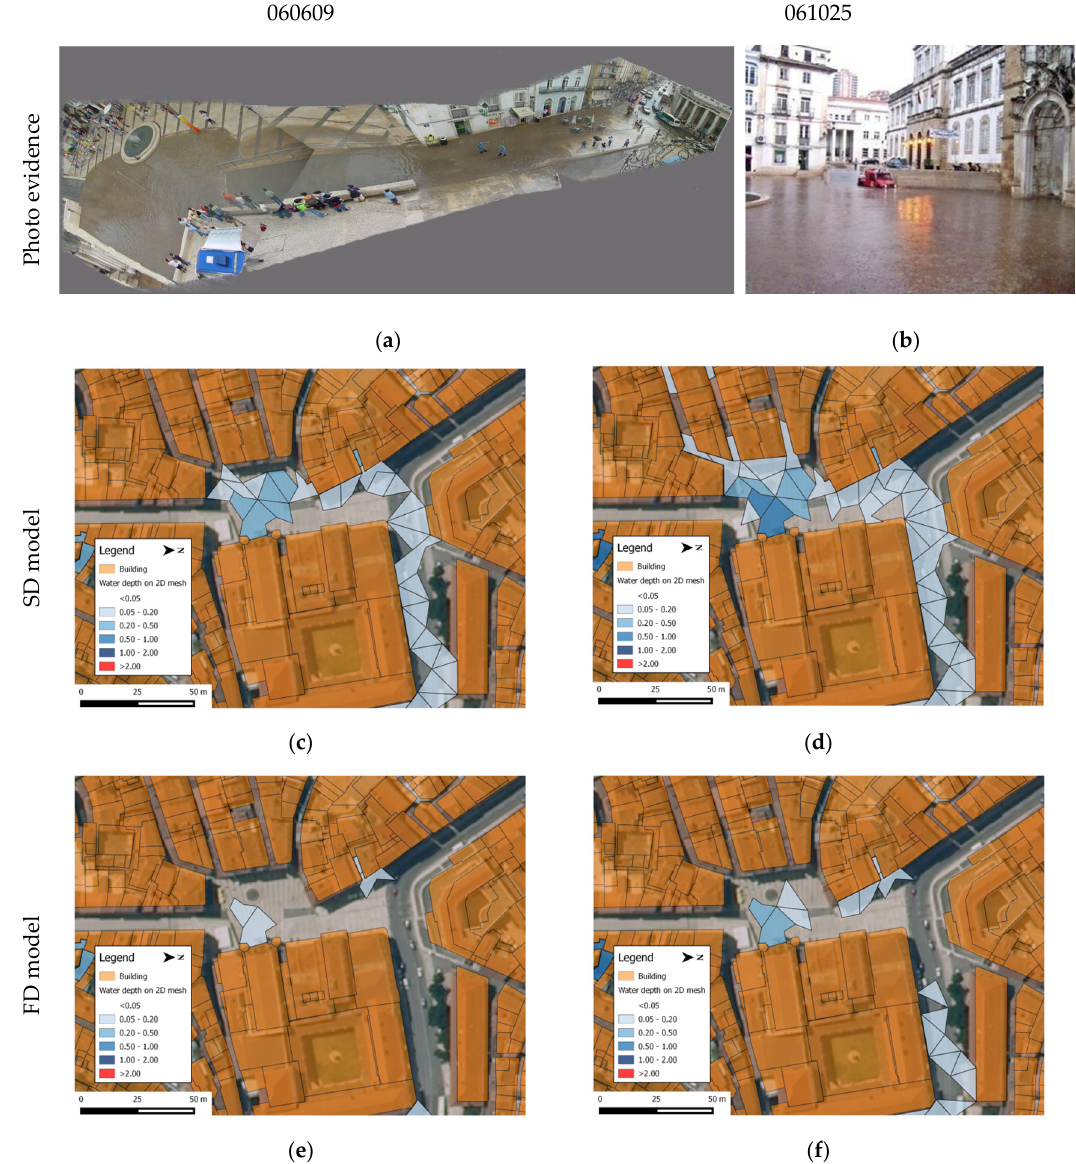
Figure 13. Comparison of photograph records with predicted floodplains on Praça 8 de Maio, Zona Central case study. ( a ) Flood registered on Event 060609, photo adapted from [38]; ( b ) Flood registered on Event 061025, photo courtesy of local newspaper Diário de Coimbra; ( c ) Floodplain generated by the SD model for Event 060609; ( d ) Floodplain generated by the SD model for Event 061025; ( e ) Floodplain generated by the SD model for Event 060609; ( f ) Floodplain generated by the FD model for Event 061025.